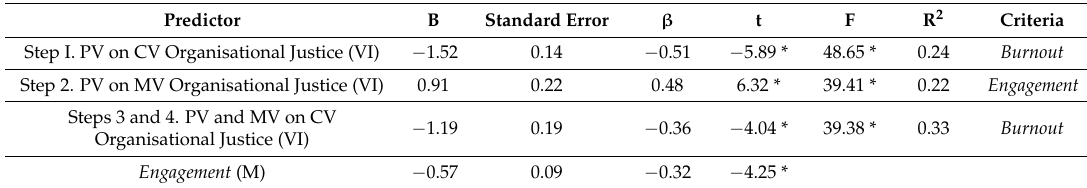
Table 3. Analysis of engagement as mediating variable in the relationship between organisational justice and burnout.